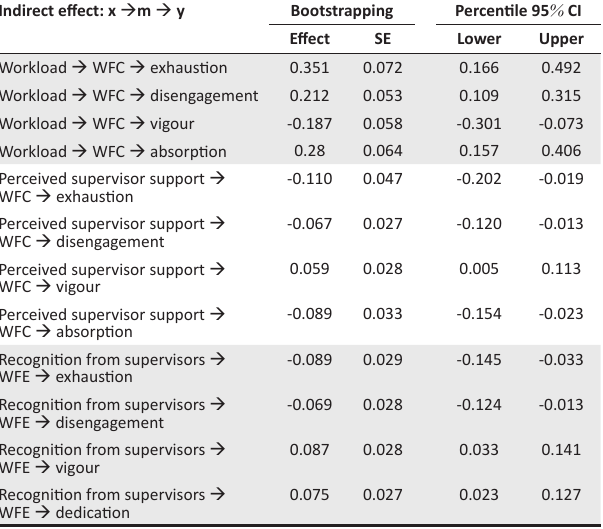
TABLE 4: Indirect pathways using bootstrapping (Hypotheses 1 and 2) ( N = 226). Indirect effect: x à m à